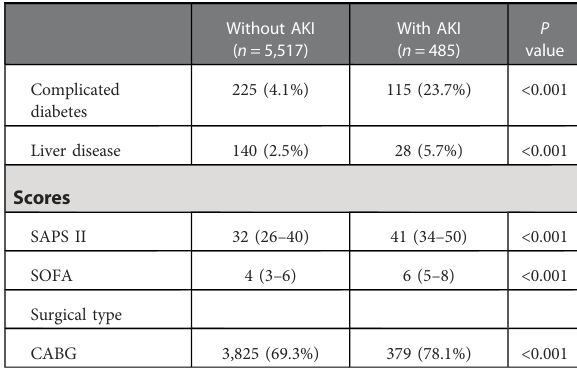
TABLE 1 Comparison of baseline characteristics between cardiac surgery patients with or without AKI.